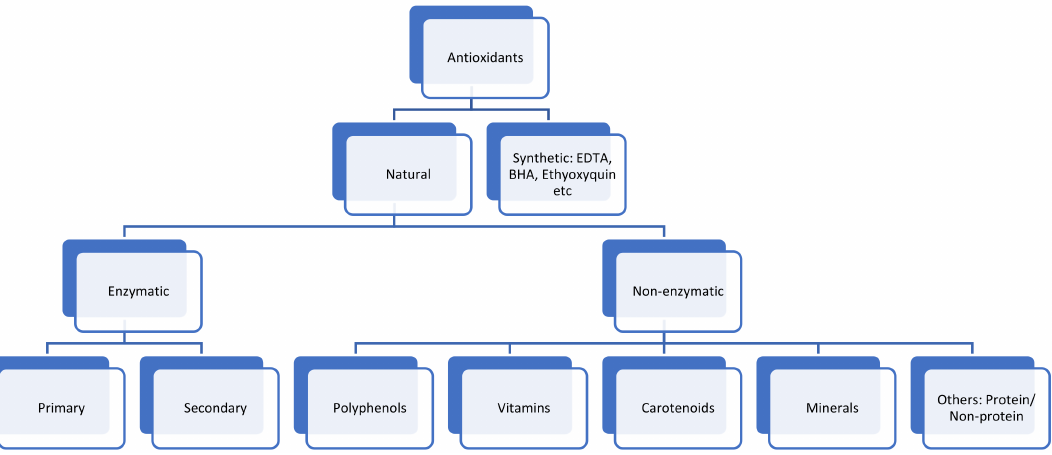
Figure 5. Schematic representation of